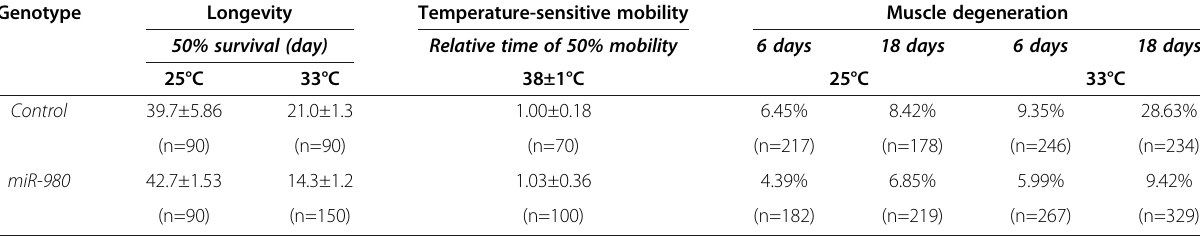
Table 2 Muscular dystrophy-related phenotypes in miR-980 mutants Genotype Longevity